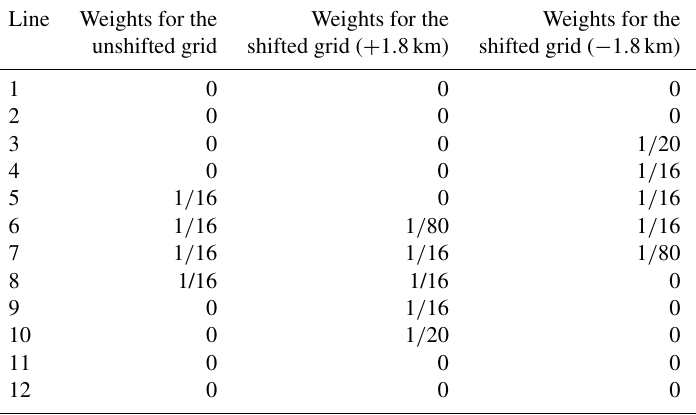
Table 2. Contribution of SGLI pixels to shifted and unshifted averaging grids for a single 3MI pixel. These weights are intended to simulate the along-track motion of the satellite. Line Weights for the Weights for the